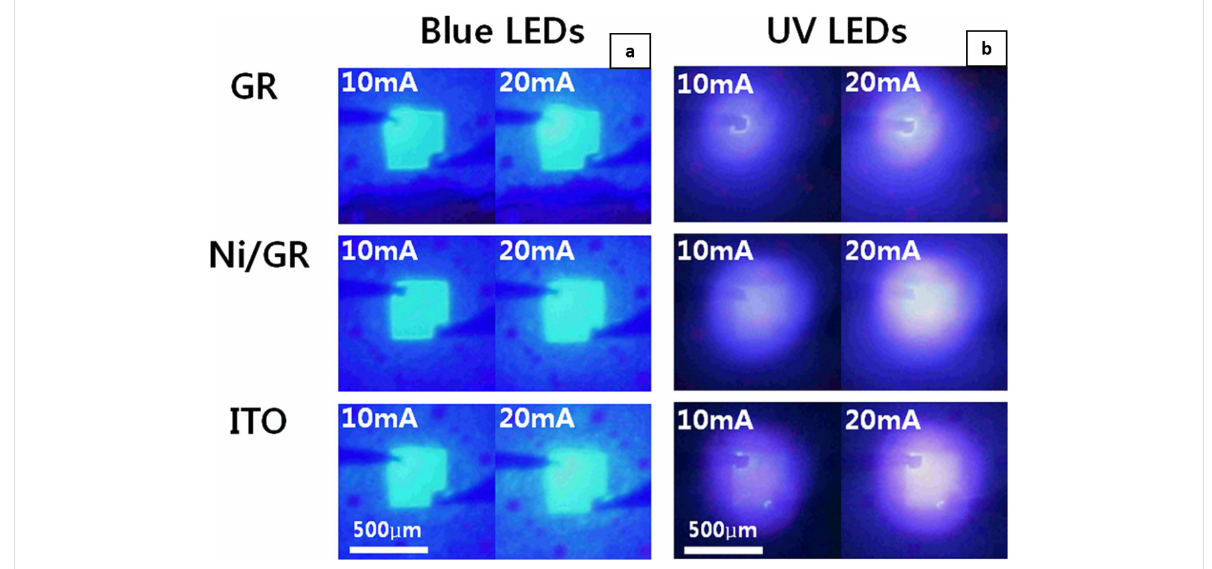
Figure 3: Optical images of light emission of (a) blue and (b) UV LED under different current-spreading layers (ITO, Ni on graphene, and graphene) at 1 and 20 mA current injections, respectively. Figure 3a and Figure 3b were adapted from [42], with the permission of AIP Publishing. This content is not subject to CC BY